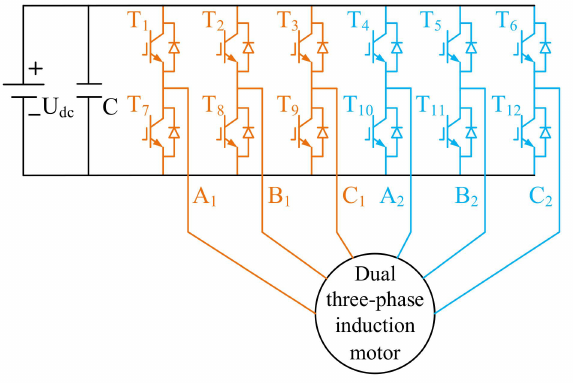
Figure 2. Dual three-phase drive system.